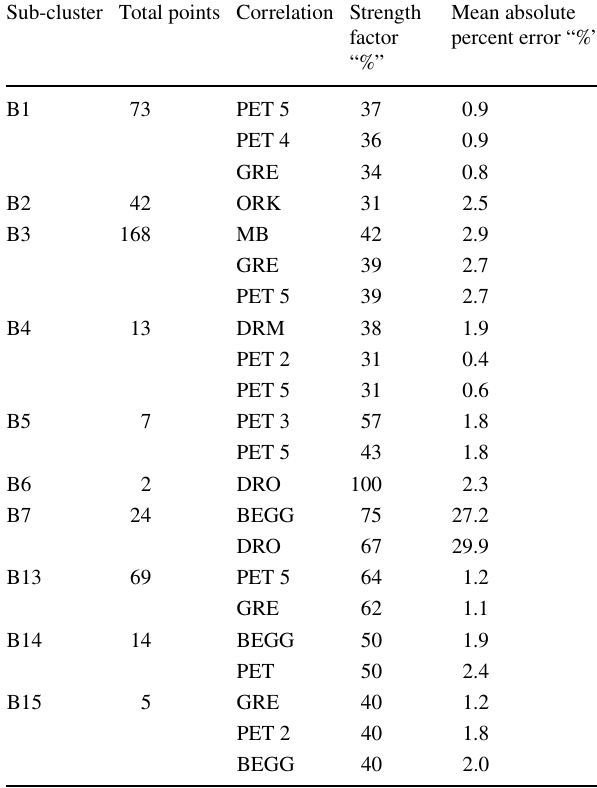
Table 10 Best correlations for cluster